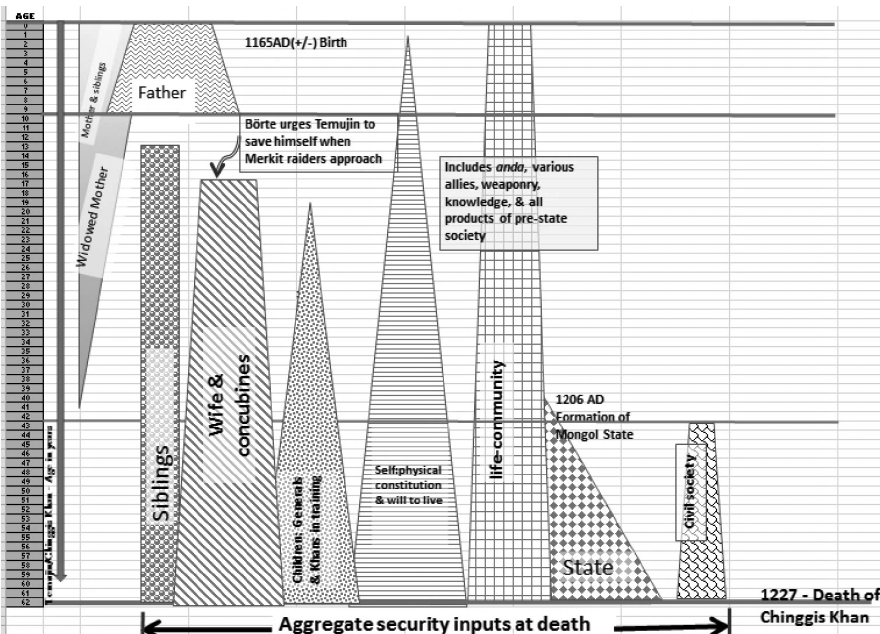
Figure 4: Security inputs to the life of Genghis